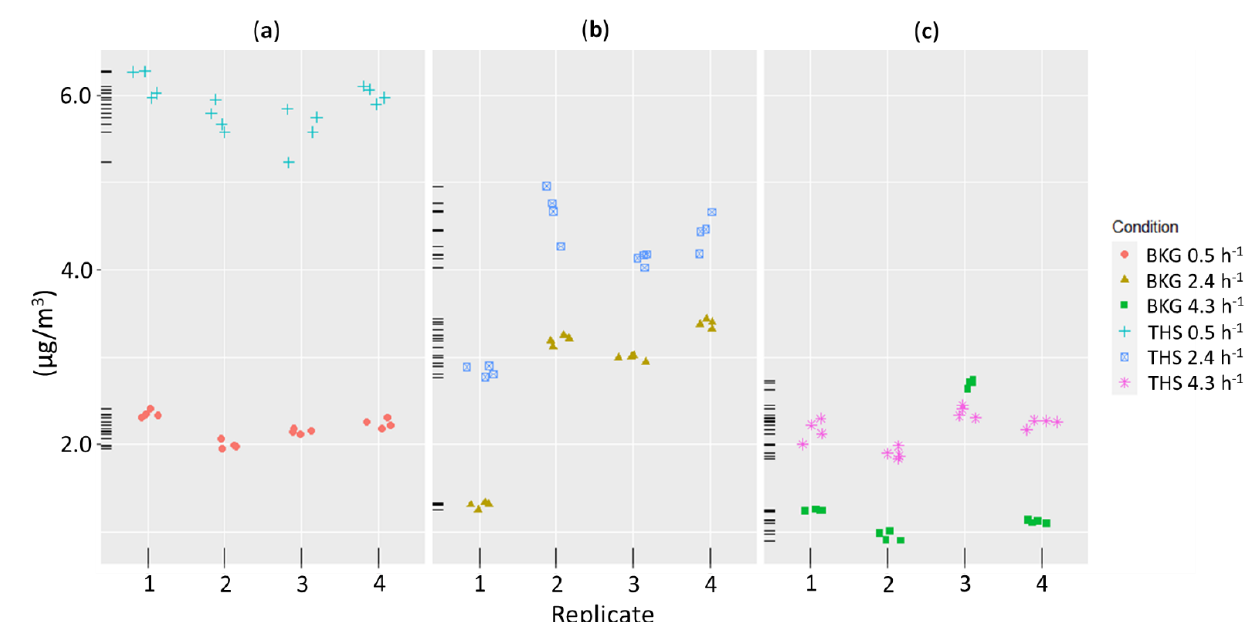
Figure 1. Comparison of the concentrations of airborne nicotine (µg/m 3 ) in the background (BKG) and THS 2.2 use sessions